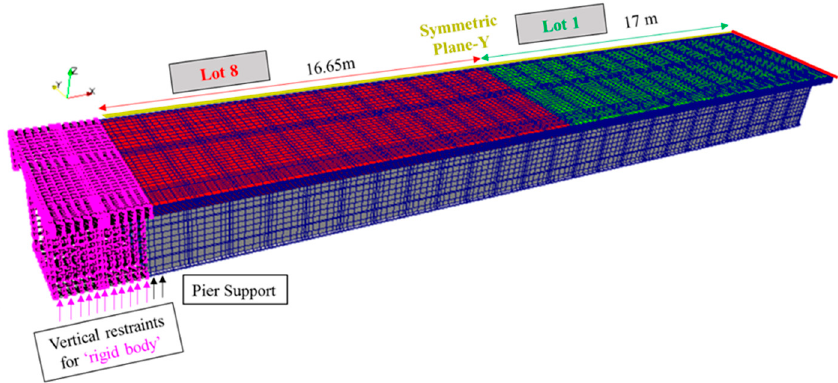
Figure 19. Overview of Shinkesen Bridge and the casting sequence (Red circle = Gauge location).